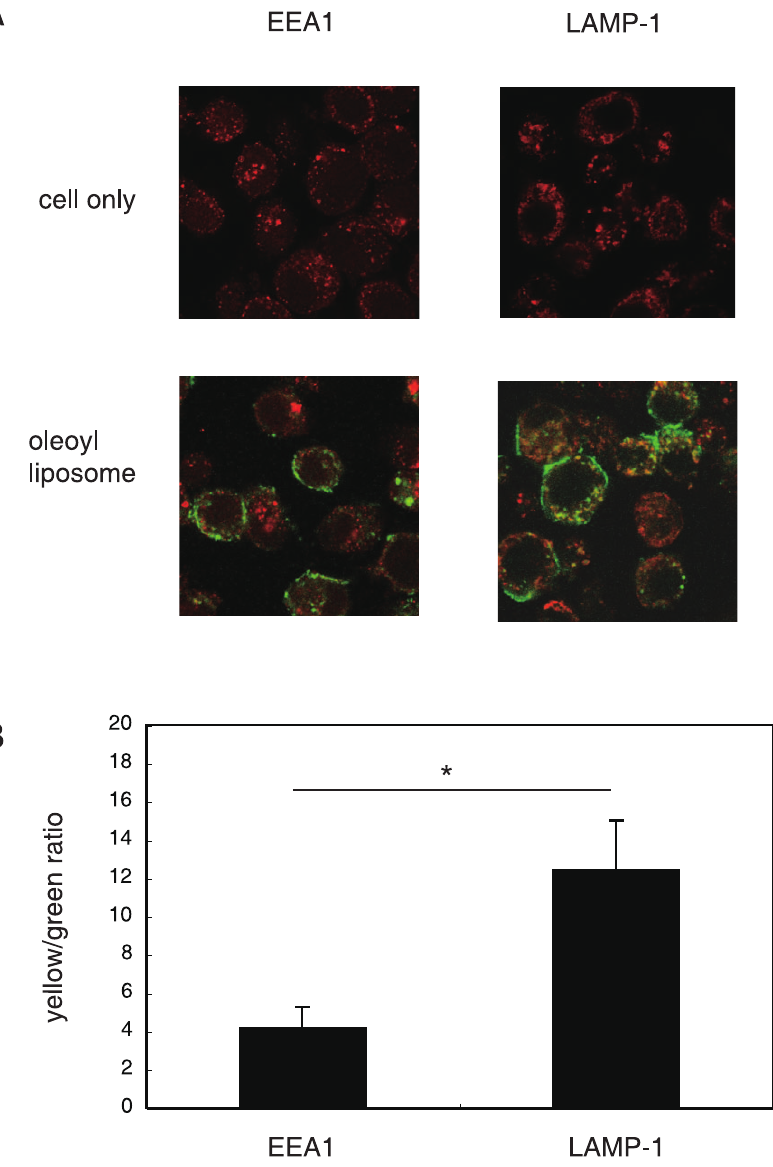
Figure 4. Intracellular localization of liposomal antigens taken up by macrophages. A, DQ-OVA was coupled to oleoyl liposomes and added to the culture of cloned macrophages of which endosomal marker EEA1-positive compartments, or lysosomal marker LAMP-1-positive compartments were stained as described in Materials and Methods. Two hours after the onset of the culture, macrophages were recovered and analyzed using confocal laser scanning microscopy. These optically merged images are representative of most cells examined by confocal microscopy. Yellow, co-localization of green (DQ-OVA after proteolytic degradation) and red (macrophage EEA1 or LAMP-1); cell only, macrophages without co-culture with DQ-OVA liposomes. B, the green- and yellow-color compartments in the immunofluorescent pictures were quantified by the image analysis software MetaMorph, as described in Materials and Methods. Ratios of the yellow to green compartments are shown. Data represent the mean values 6 SD of the images shown in Fig, 4A. Asterisk, significant ( p , 0.01) difference of samples.